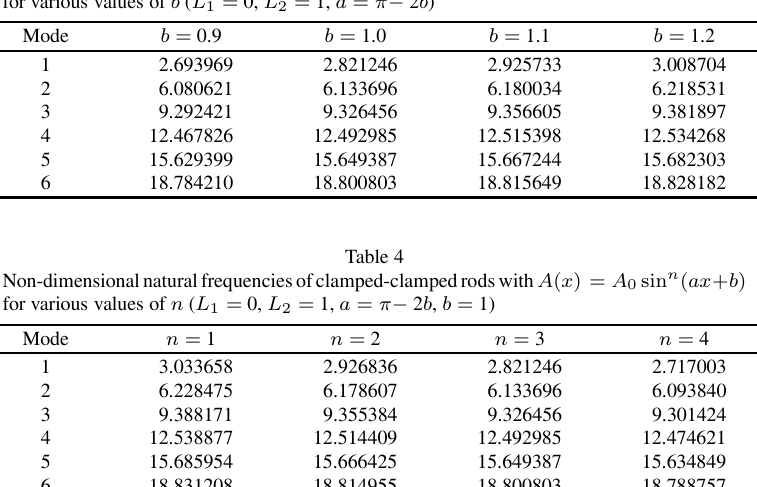
Table 3 Non-dimensional natural frequencies ofclamped-clamped rodswith A ( x ) = A 0 sin 3 ( ax + b )